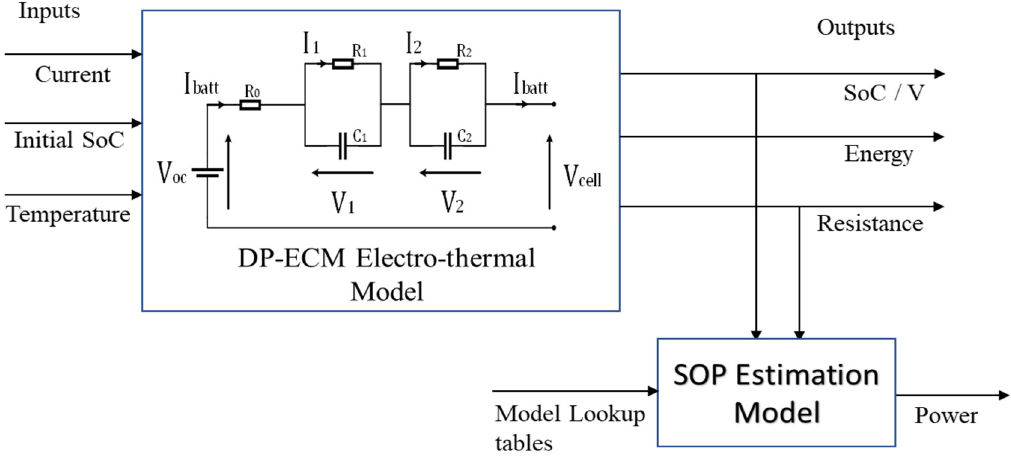
Figure 9. Schematic representation of DP_ECM coupled SoP battery model.